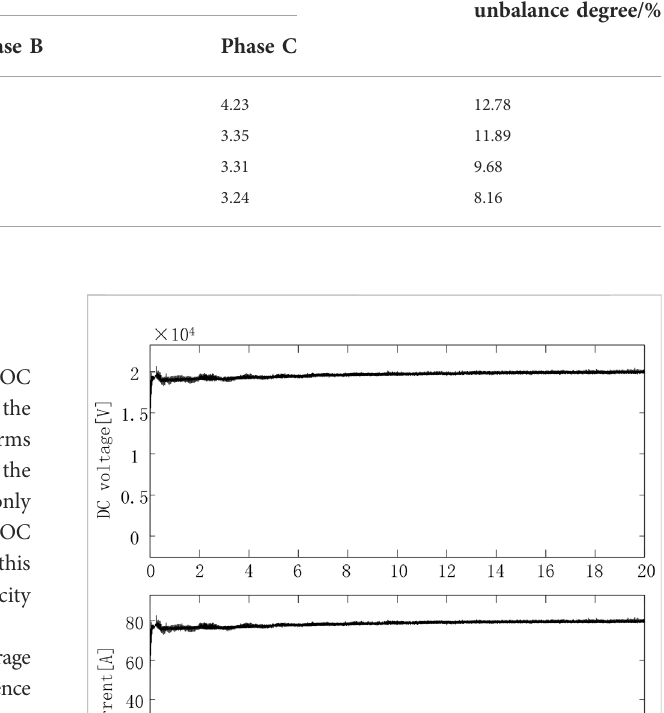
TABLE 5 FFT analysis of AC side three-phase current and analysis of three-phase unbalance degree. Time (s)